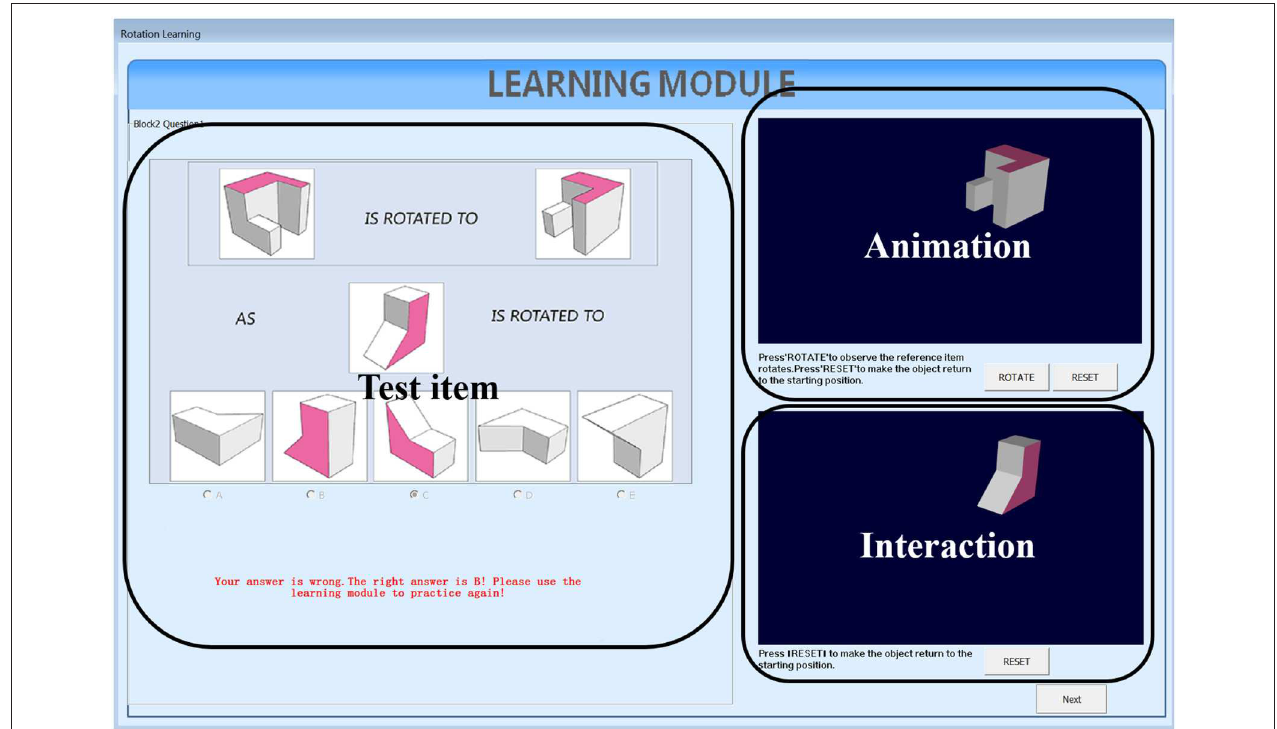
FIGURE 4 | Colored